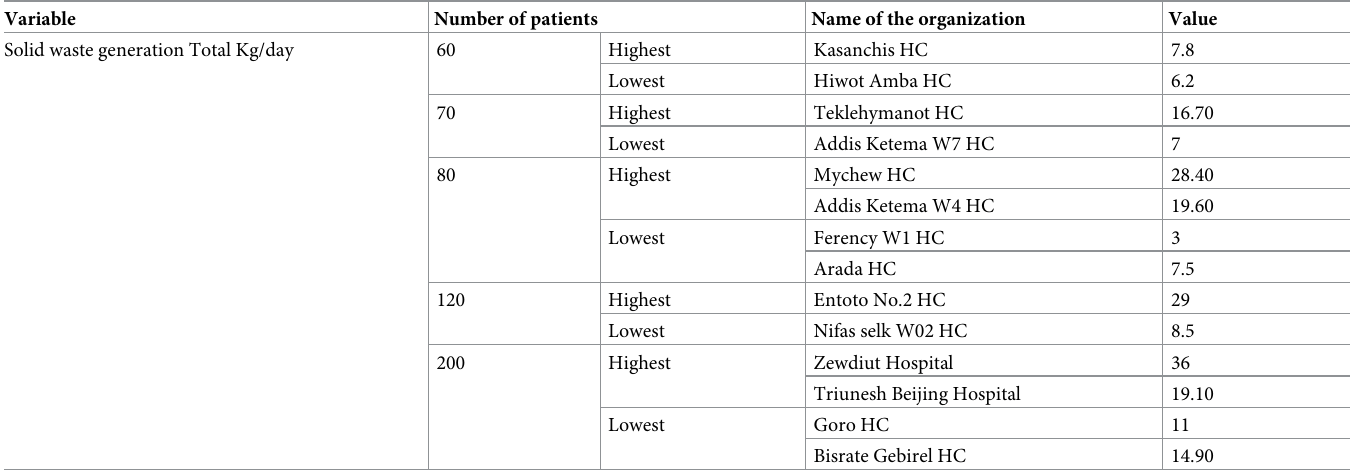
Table 4. Comparison of biomedical waste generation rate with number of patients per day getting a laboratory service in public health care facilities (n = 26). Variable